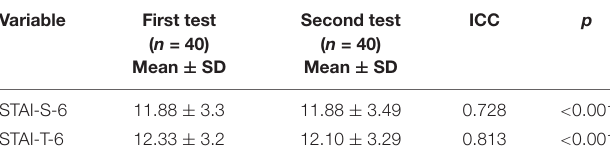
TABLE 9 | Intraclass correlation coefficients (ICCs) for the scores of the STAI-S-6 and STAI-T-6 scales between the initial and second tests.